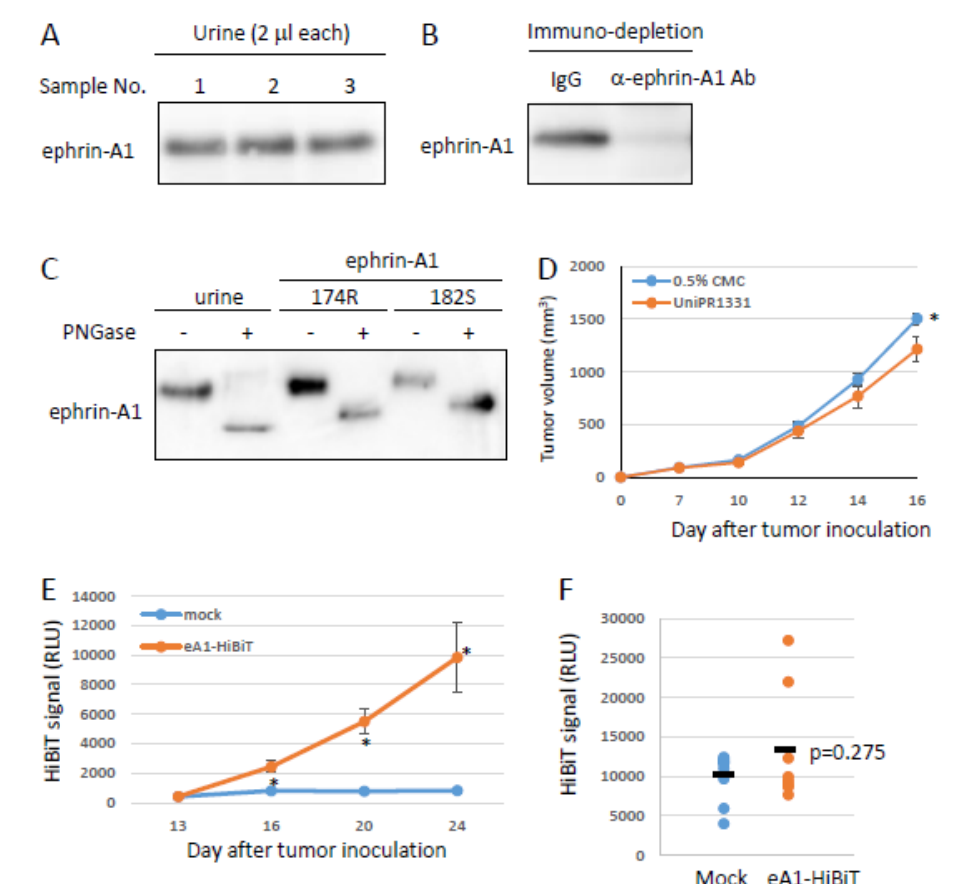
Figure 6. A putative biomarker of lung metastasis. ( A ) Urinary ephrin-A1 in mice. Urine was collected from healthy mice and analyzed by immunoblotting. Two microliters of urine were used for immunoblotting. ( B ) Immuno-depletion of urinary ephrin-A1. Two microliters of urine were incubated with anti-ephrin-A1 antibody. The immune complex was precipitated with Protein G beads, and the supernatant was analyzed by immunoblotting. Urinary ephrin-A1 was disappeared by an incubation with anti-ephrin-A1 antibody. ( C ) Glycosylation of mouse urinary ephrin-A1. Mouse urinary ephrin-A1 was treated with PNGase. Mouse urinary ephrin-A1 was shifted down. ( D ) Effects of soluble ephrin-A1 174R on tumor growth. LLC cells stably expressing a soluble form of HiBiT-tagged ephrin-A1 174R were subcutaneously inoculated into B6 mice. Tumor mass was measured by a caliper, and ( E ) serum and ( F ) urine were collected from the mice twice a week. Serum levels of HiBiT-ephrin-A1 were markedly elevated 16 days after tumor inoculation. HiBiT-ephrin-A1 in urine was detected in some mice but not all. ( n = 8, * p < 0.05).